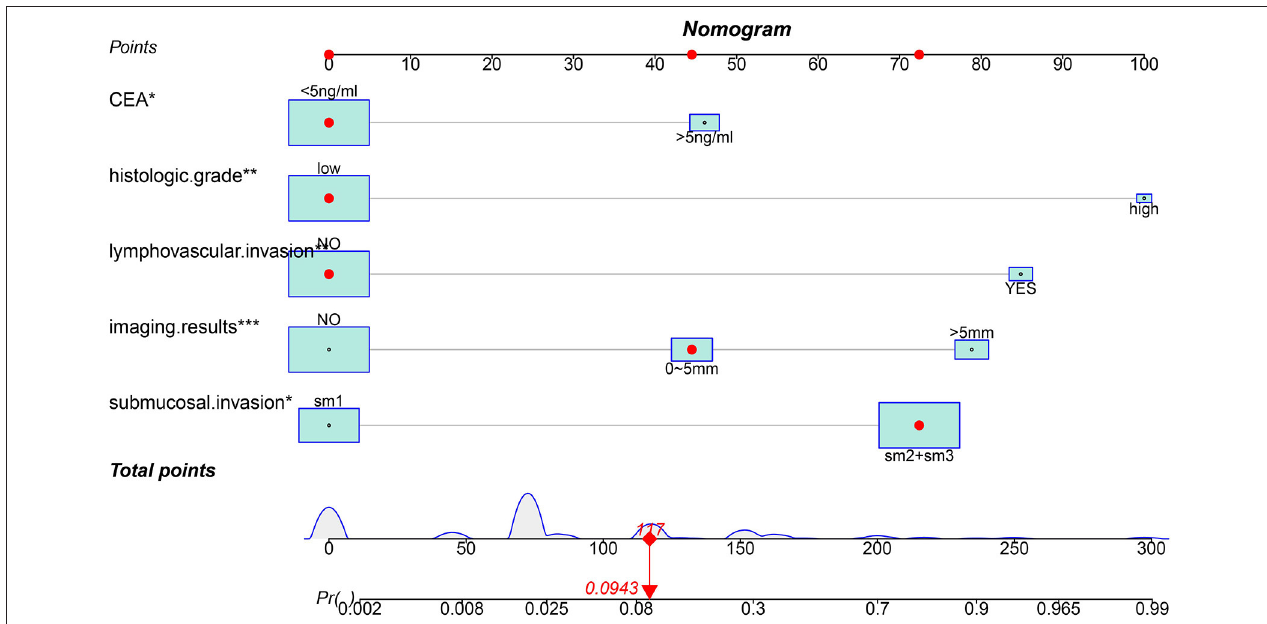
FIGURE 2 | The nomogram for predicting lymph node metastasis in T1 colorectal cancer.